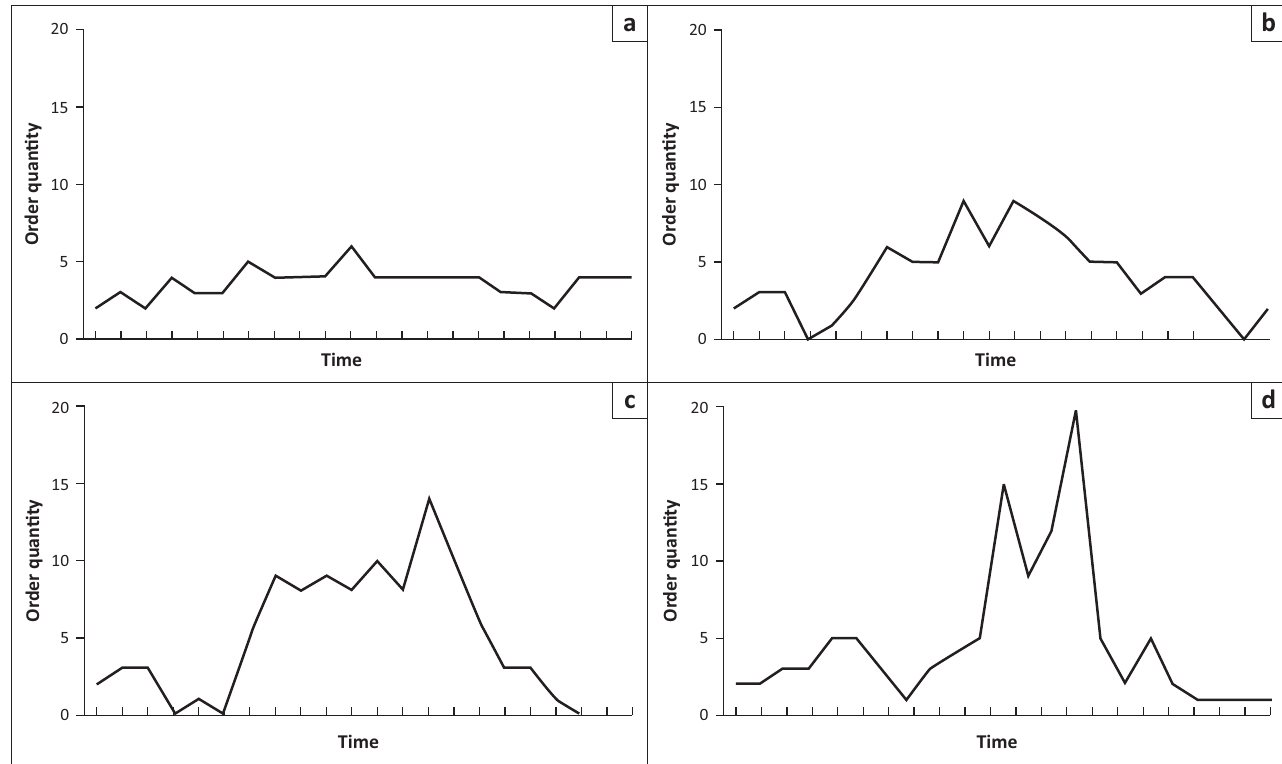
FIGURE 1: Bullwhip effect – Increased variability of orders up the supply chain. (a) Consumer sales, (b) retailer’s order to manufacturer, (c) wholesaler’s orders to manufacturer and (d) manufacturer’s order to